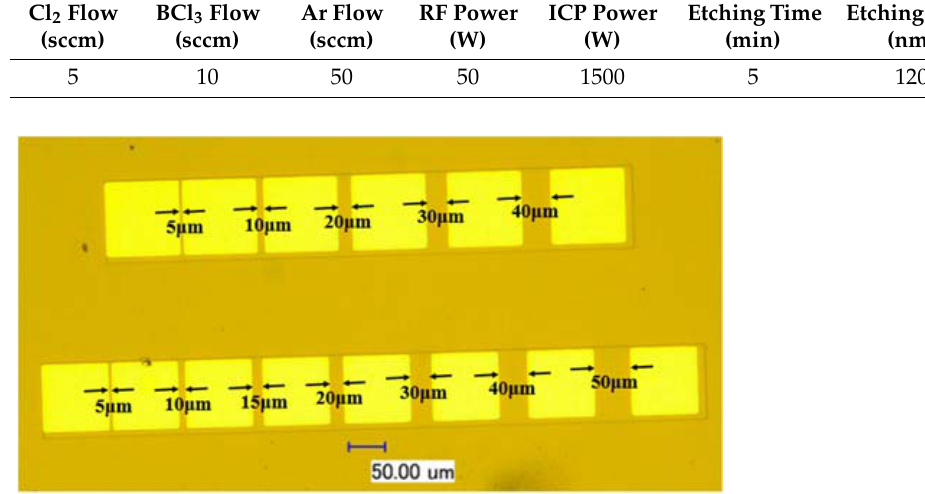
Figure 5. The top view of the prepared TLM electrodes